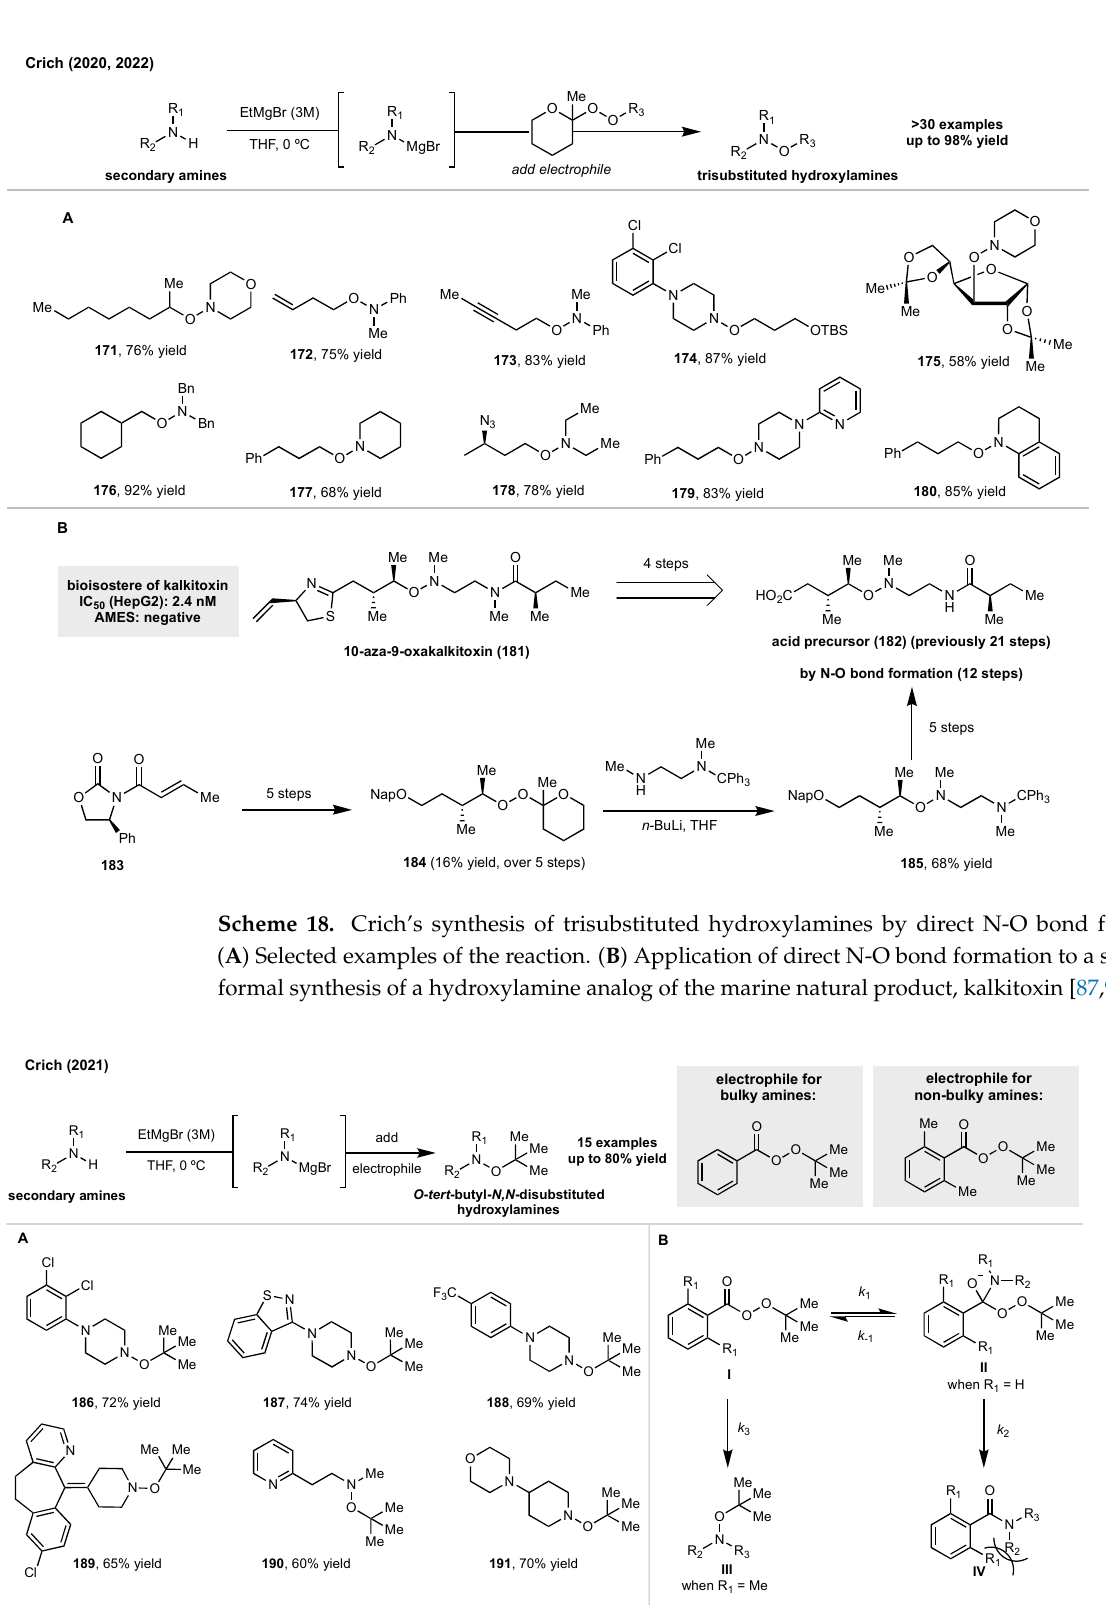
Scheme 19. Crich(cid:31)s synthesis of O-tert -butyl- N , N -disubstituted hydroxylamines by direct N-O bond formation using sterically matched electrophiles. ( A ) Selected examples of the reaction. ( B ) Pro- posed reaction pathway accounting for selective addition